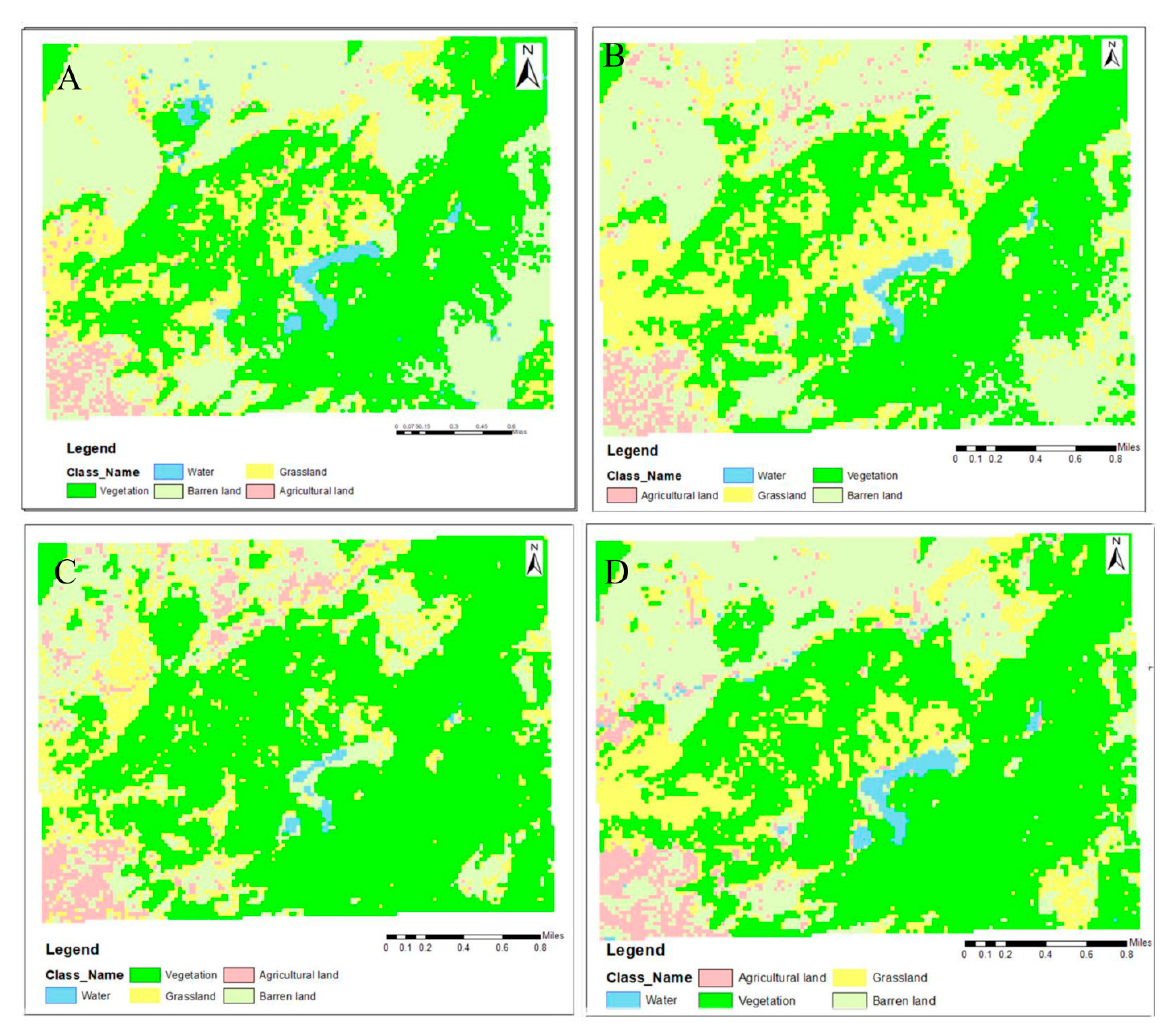
Figure 2. Patterns of land use and land cover from 1989–2021. ( A ) LULC of the RWC for 1989; ( B ) LULC of the RWC for 2000; ( C ) LULC of the RWC for 2010; and ( D ) LULC of the RWC for 2020. Table 3. Spatial extent of land cover classes in